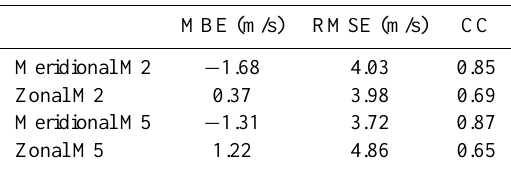
Table 6. Hourly and daily statistics for the wind speed compo- nents in terms of mean bias error (MBE) and root mean square error